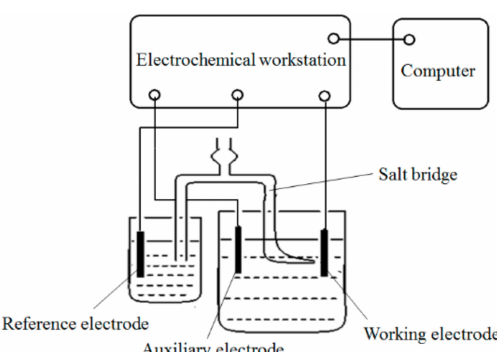
Figure 5. Diagram of the electrochemical test circuit and